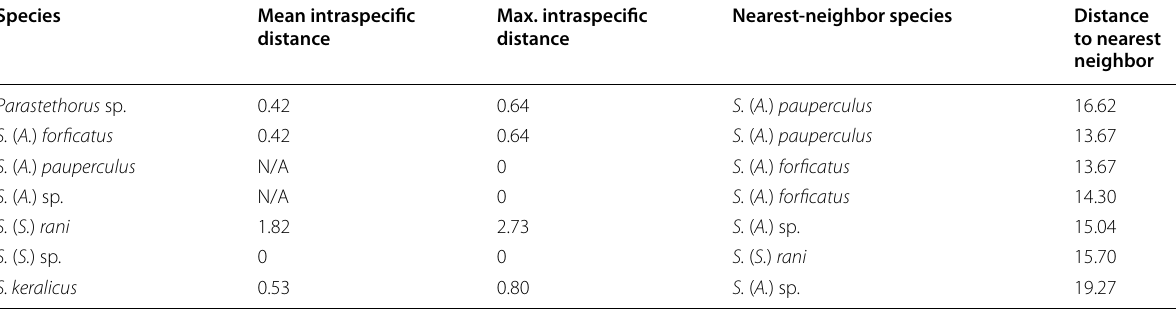
Nearest-neighbor species Distance